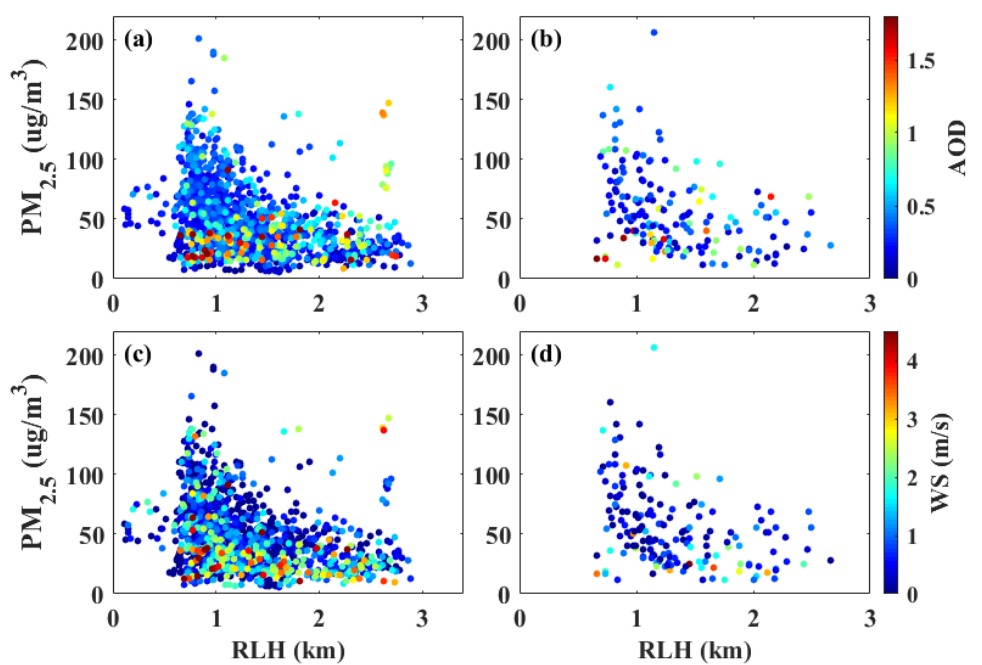
Figure 7. Relationship between hourly mean RLHs and PM 2.5 with changes in ( a ) AOD, and ( c ) WS. Relationship between daily mean RLHs and PM 2.5 on the next day with changes in ( b ) AOD, and ( d ) WS.